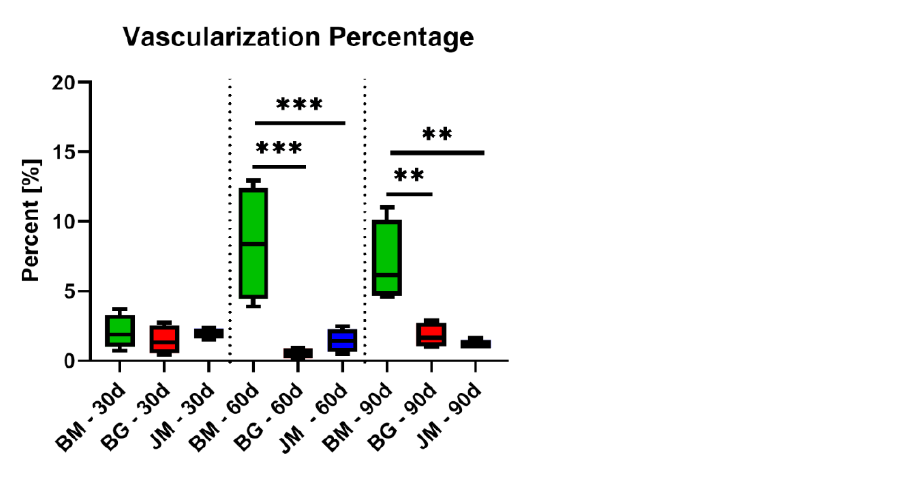
Figure 17. Results of the histomorphometrical measurements of the percent vascularization of the membrane areas (* = intraindividual differences; **: p < 0.01 and ***: p < 0.0001). BM: bovine membrane, JM: Jason ® membrane, BG: Bio-Gide ® .